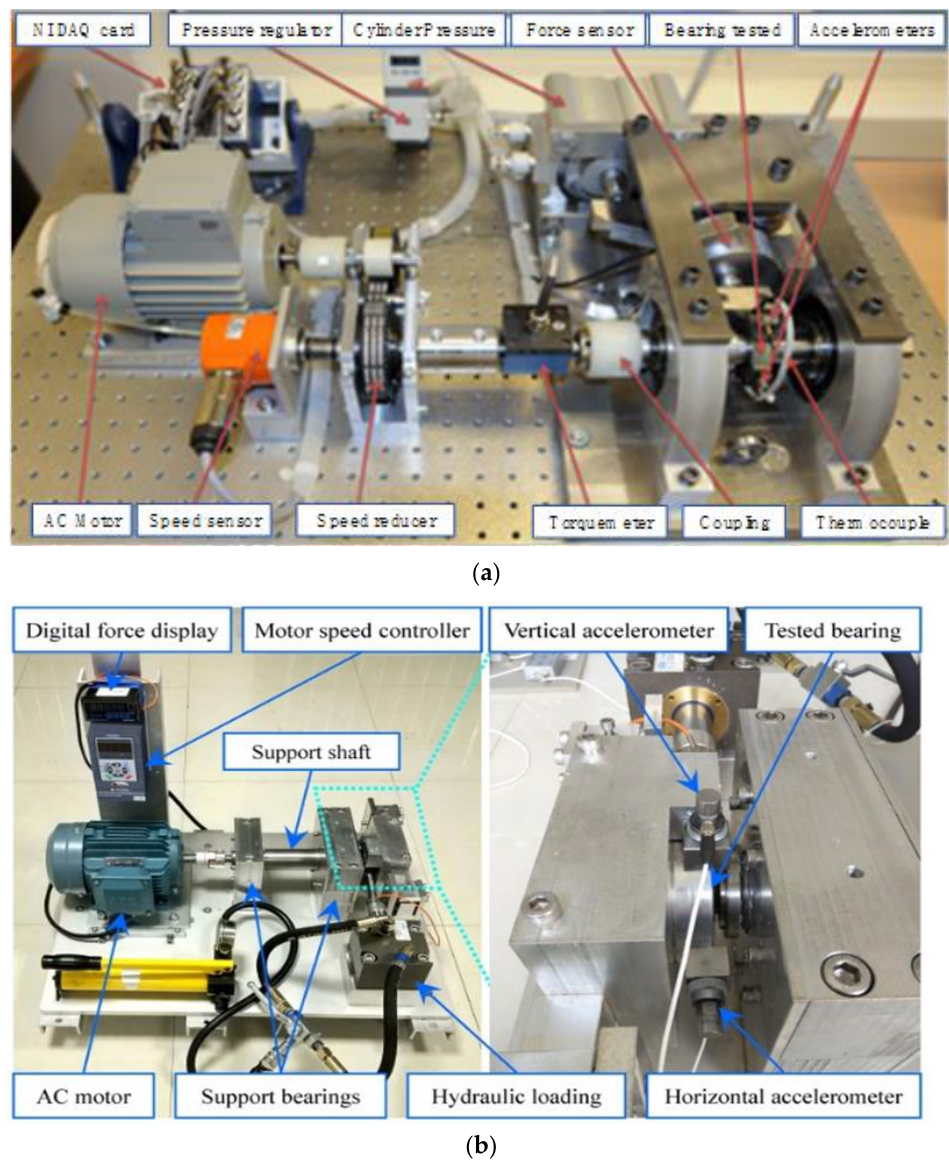
Figure 3. Test platforms of ( a ) PRONOSTIA [32] and ( b ) XJTU-SY [33]. The XJTU-SY dataset is provided by the Institute of Design Science and Basic Component at Xi’an Jiaotong University (XJTU) [33], China and the Changxing Sumyoung Technology Co., Ltd. (SY), Zhejiang province, China. The platform is shown in Figure 3b. Three kinds of experimental working conditions were designed in this experiment, and five bearings were tested in each working condition. (1) The engine speed is 2100 rpm and the load is 12 kN. (2) The engine speed is 2250 rpm and the load is 11 kN. (3) The speed is 2400 rpm and the load is 10 kN.